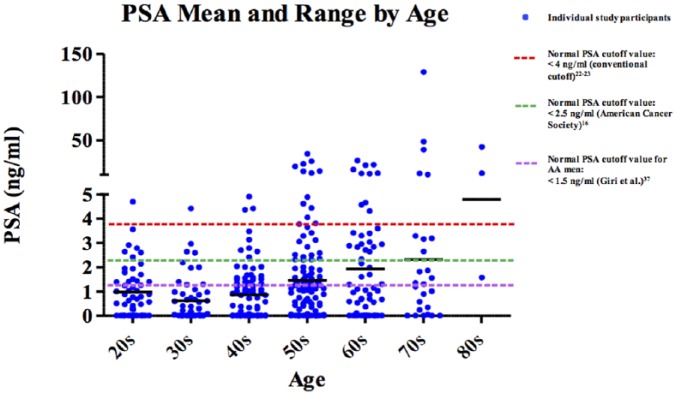
PSA values of AA/Black study participants differentiated by reported
normal cutoffs. Serum PSA levels in sera of the study participants were
determined by ELISA. As expected, average PSA levels increased with age,
with PSA of men in their 30s averaging 0.8 ng/ml and PSA of men in their
80s averaging 16.4 ng/ml. We identified participants who had
higher-than-normal PSA in the context of differing numerical values for
what is considered higher-than-normal PSA levels for AA men. While the
conventional cutoff for higher-than-normal PSA levels is 4 ng/ml, the
American Cancer Society currently advises repeat screening for men with
PSA levels greater than 2.5 ng/ml, and one study suggests 1.5 ng/ml as a
predictor for PCa in AA men (American Cancer Society, 2017;
Giri et al.,
2009). Our results revealed that 33.3% of study participants
had higher-than-normal PSA levels. Of these, 12.1% of participants
(50/414) had PSA levels >4 ng/ml, 9.4% (39/414) had detectable PSA
levels between 2.5–3.9 ng/ml, and 11.8% (49/414) had detectable PSA
levels between 1.5–2.49 ng/ml. PSA = prostate-specific antigen; AA =
African American; enzyme-linked immunosorbent assay; PCa = prostate
cancer.